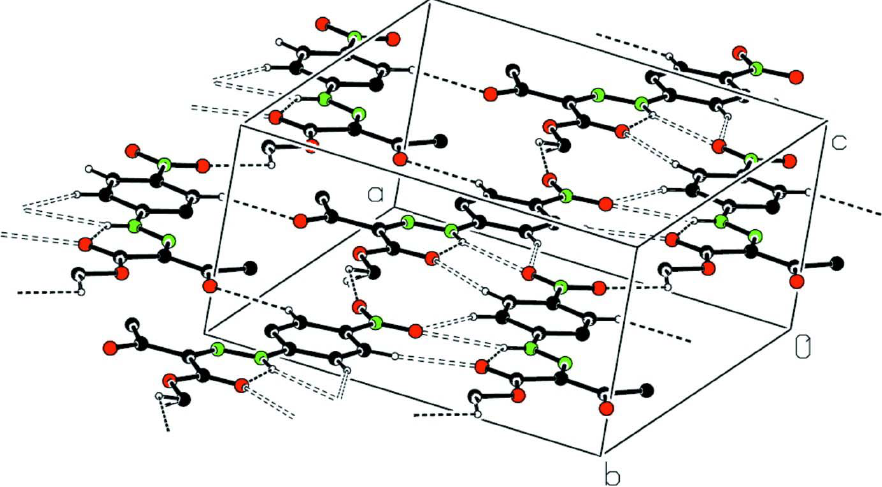
Figure 2 Part of the crystal structure of the title compound, showing the formation of a hydrogen bonded plane parallel to [001], which is built by one N—H···O and four C—H···O inter-molecular hydrogen bonds (dashed lines). For the sake of clarity, H atoms not involved in hydrogen bonding have been